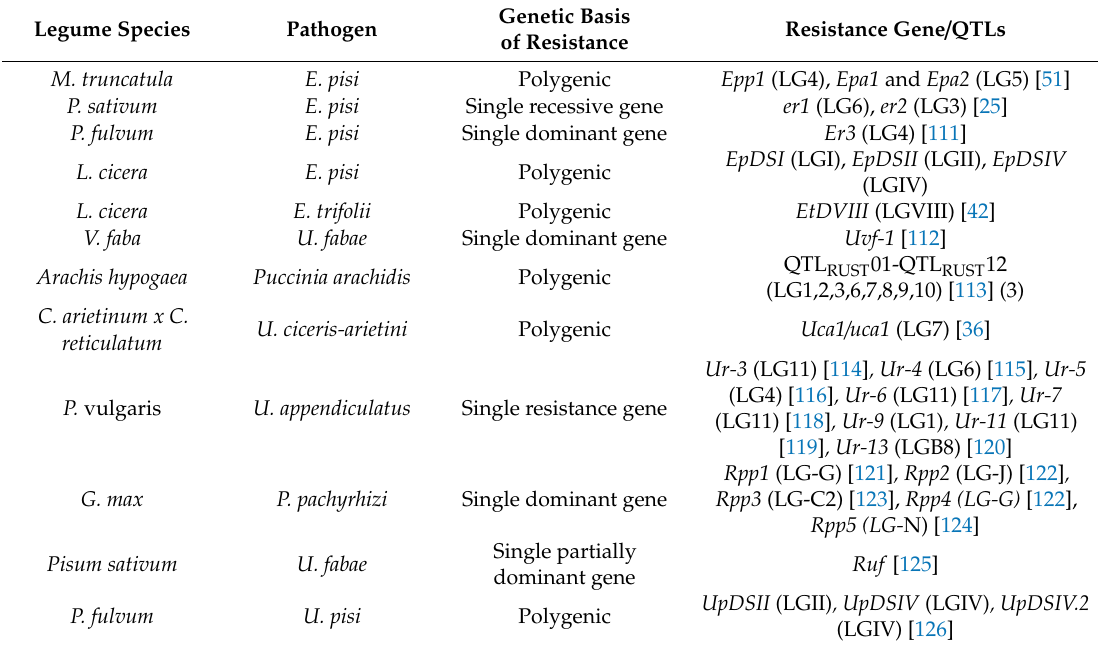
Table 1. List of resistance genes / QTLs identified in important legumes against biotrophic pathogens. Legume